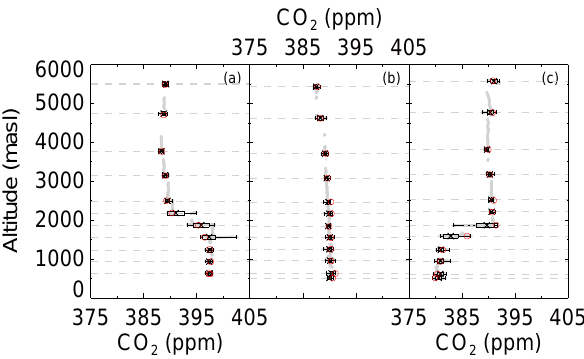
Fig. 8. Vertical profiles of CO 2 in wintertime ( a ; 18 March 2009), well-mixed condition ( b ; 20 May 2009), and summer/fall ( c ; 27 Oc- tober 2010). Gray dots shows continuous observations collected by the RM0 system. CO 2 mole fraction collected during horizontal legs of the flight have been binned to calculate simple statistics: mini- mum and maximum (black vertical segments), mean (black cross), and standard deviation (rectangle) of CO 2 mole fraction. Open red circles show CO 2 mole fraction measured from